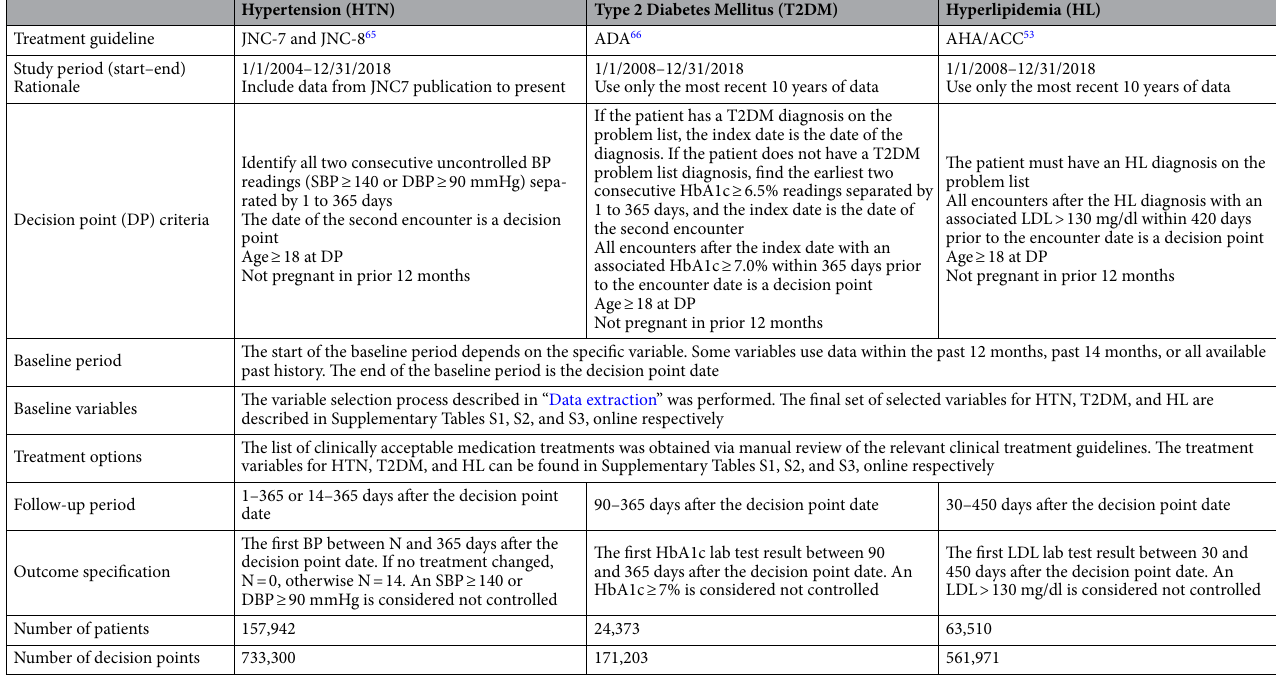
Table 2. Decision point criteria and characteristics for the three disease conditions. DP decision point, BP blood pressure, DBP diastolic blood pressure, SBP systolic blood pressure, LDL low density lipoprotein, HbA1c hemoglobin